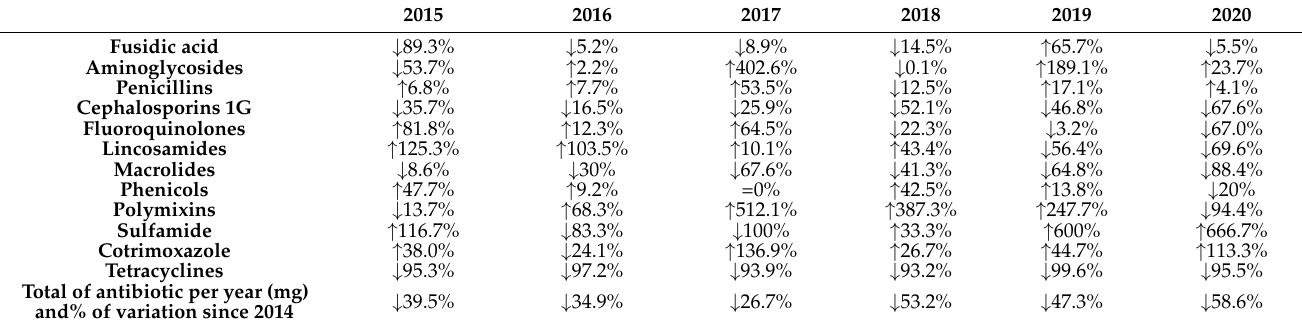
Table 5. Percentage change in antimicrobial sales in tonnage of active ingredient for each antimicrobial class or molecules compared to